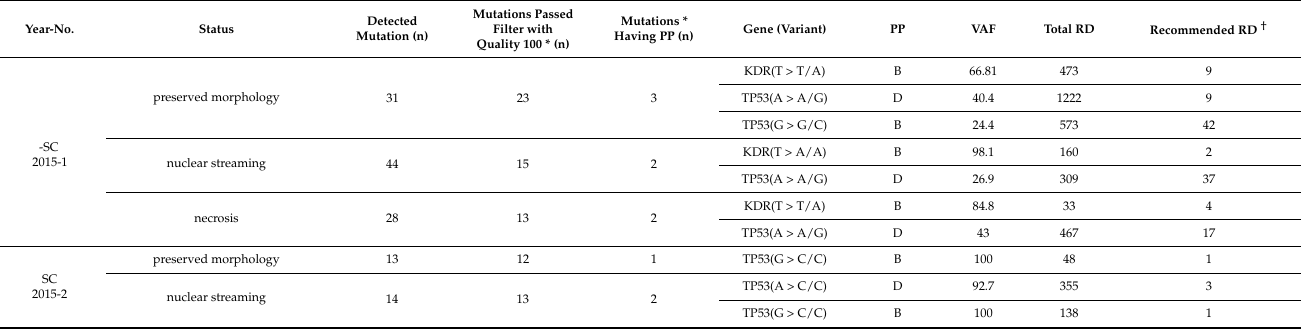
Table 3. Mutations in 25 samples obtained from 10